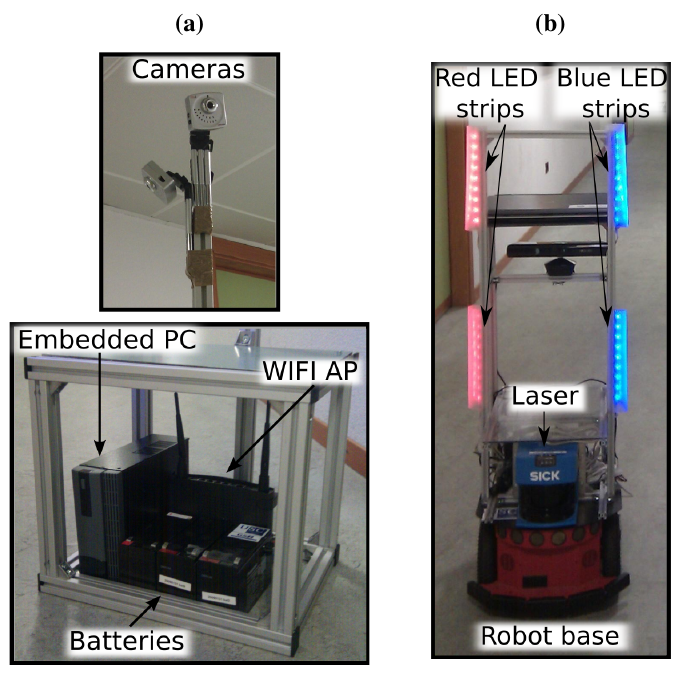
Figure 2. ( a ) Camera-agent: camera-agent’s cameras (top), and camera-agent’s box with embedded PC, batteries and WiFi AP (left-bottom). ( b ) Robot-agent, with its laser range finder and LED strips for identification from the